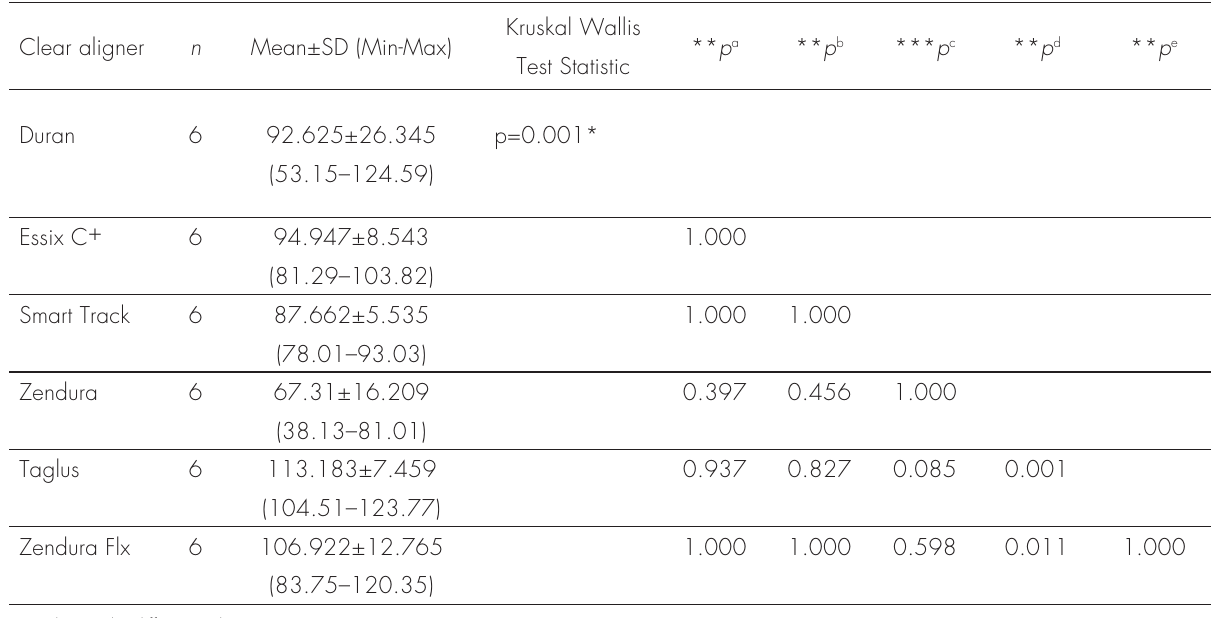
Table II. Cell proliferation obtained from MTT analysis.